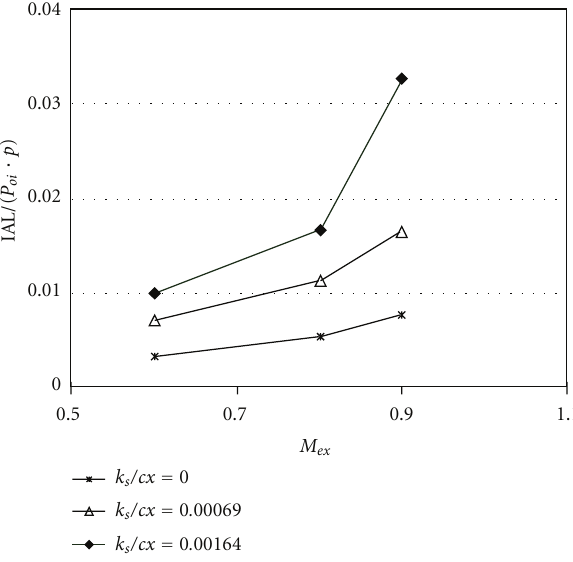
Figure 7: For Tu = 0 . 9%, comparison of normalized Integrated Aerodynamic Loss as dependent upon the exit Reynolds number for the smooth airfoil ( k s /cx = 0), the airfoil with small roughness ( k s /cx = 0 . 00069), and the airfoil with large roughness ( k s /cx = 0 . 00164) for the symmetric airfoil investigations